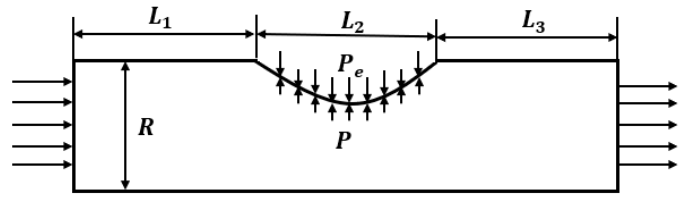
Figure 3. Vascular collapse model.